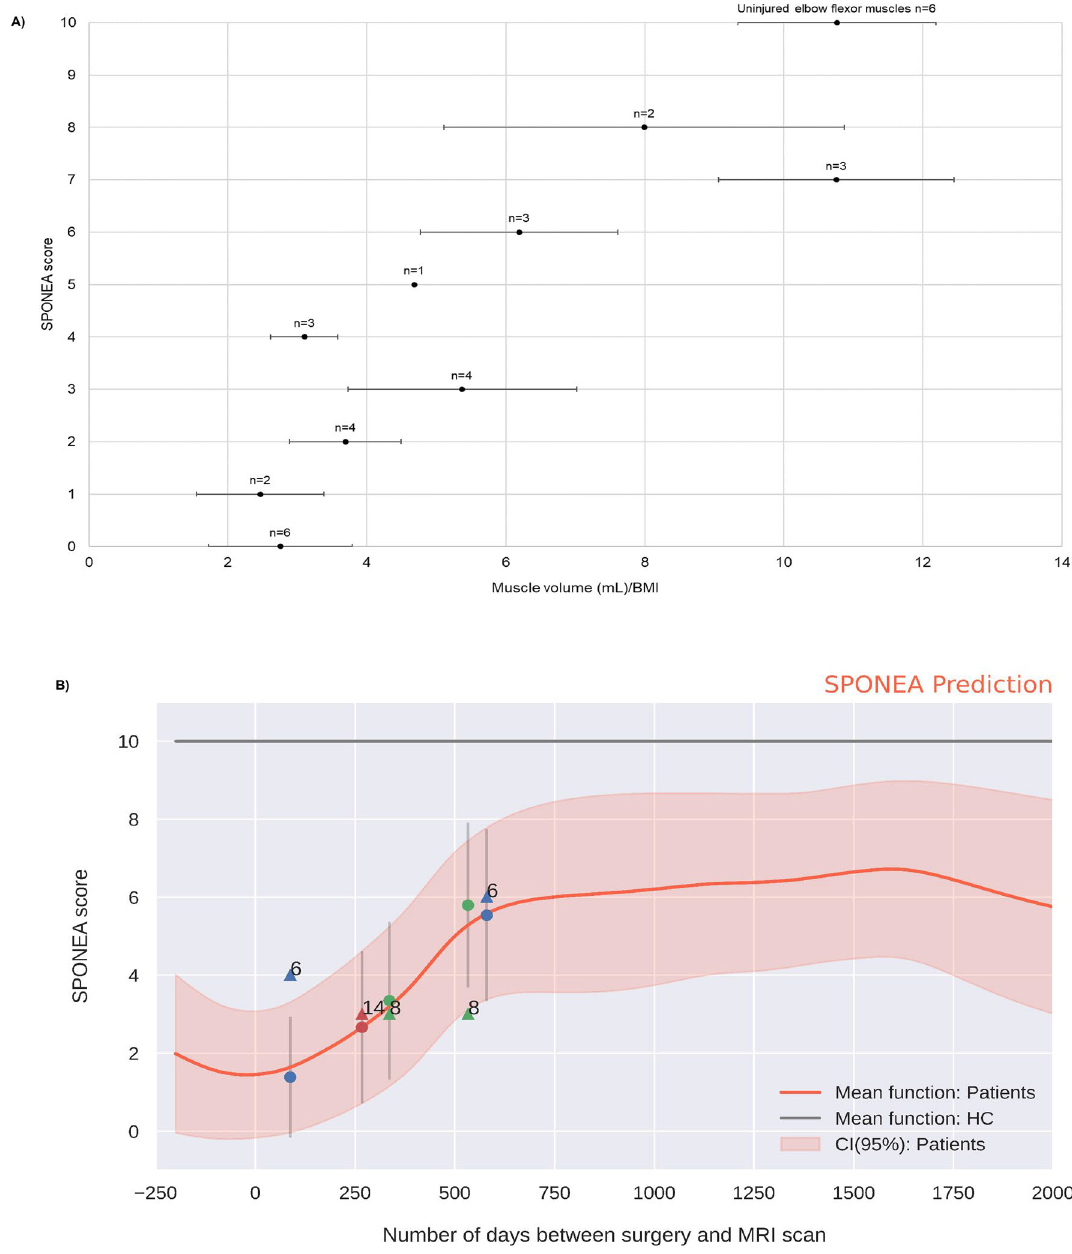
Figure 3. Relationship between muscle volume per unit BMI and SPONEA. (A) Relationship of the mean muscle volume per unit BMI with the SPONEA scale. The error bars represent one standard deviation. ( B) Application of the HGP to the data presented in ( A) . The numbers attached to the data points are in reference to the case numbers provided in Additional file 1. The circular data points represent the predicted values on the triangular points denote the actual data